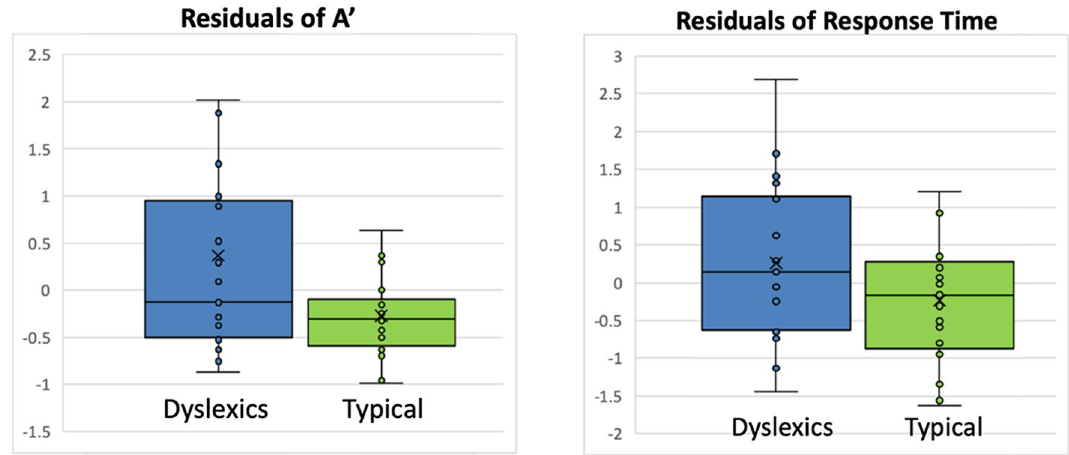
Figure 3. Centralized Residuals of A ′ (left) and response time (right) as computed with regression method 12 .